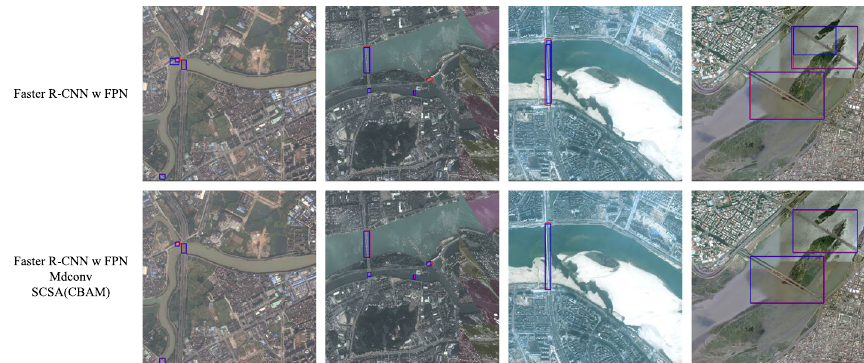
The significance for bold values is only highlighted on the best performance